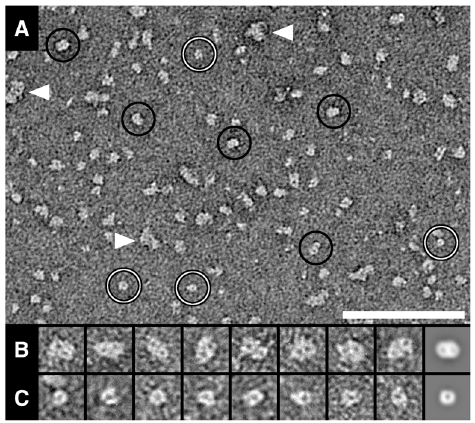
Figure 3. Negative stain-TEM and SPA of purified hSVCT1. (A) Overview electron micrograph of purified hSVCT1 adsorbed on a parlodion carbon-coated surface. Projections of differently oriented hSVCT1 proteins are discerned. Large, elliptical (hSVCT1 dimers) and small, round-shaped (hSVCT1 monomers) particles are marked by black and white circles, respectively. Small protein aggregates are also observed (arrowheads). Well-preserved top views of dimers (B) and monomers (C) were magnified and are displayed in the gallery. The rightmost frames in (B) and (C) display averages of dimer (n=387) and monomer (n=316) top views, respectively. In hSVCT1 dimers (B) two stain accumulations are discerned, while in monomers (C) only one. Averages are low-pass filtered to 2 nm resolution. The scale bar in (A) is 100 nm. The frame sizes in (B) and (C) are 18.5 nm.